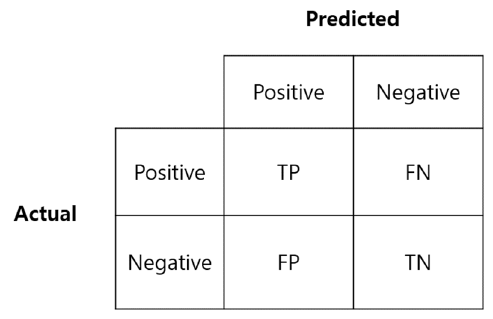
Figure 3. Confusion matrix.